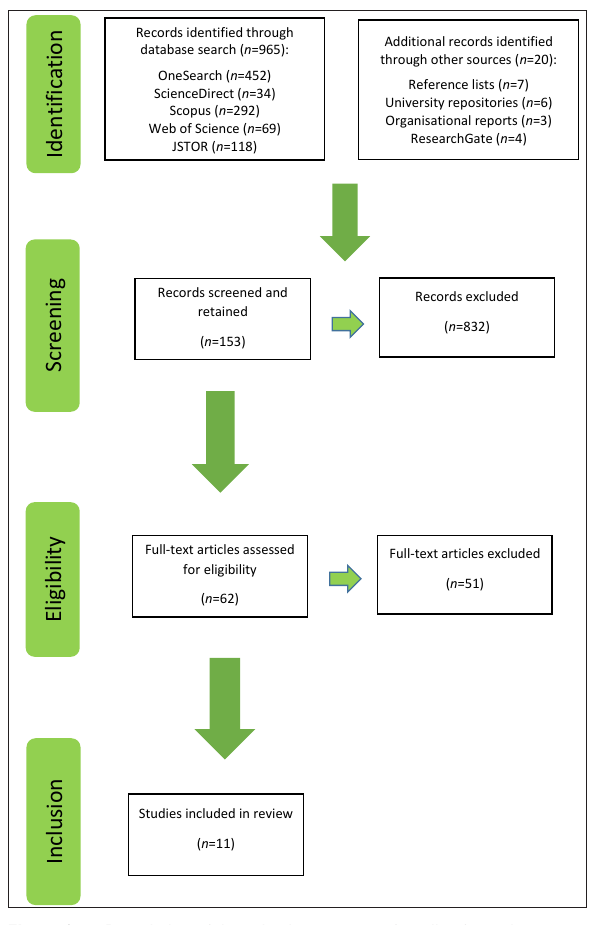
Figure 1: Description of the selection process of studies for